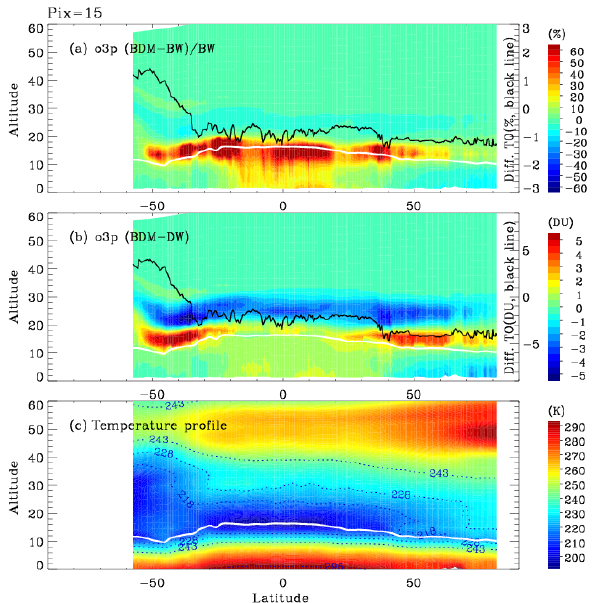
Figure 7. (a) Percent difference ((BDM–BW)/BW × 100%) of re- trieved ozone profiles using BDM and BW datasets at nadir view, (b) absolute differences in Dobson units and (c) corresponding tem- perature profiles in the retrievals. In panels (a) and (b) , the black line represents the differences of integrated column ozone. The white line in both panels represents the tropopause height.